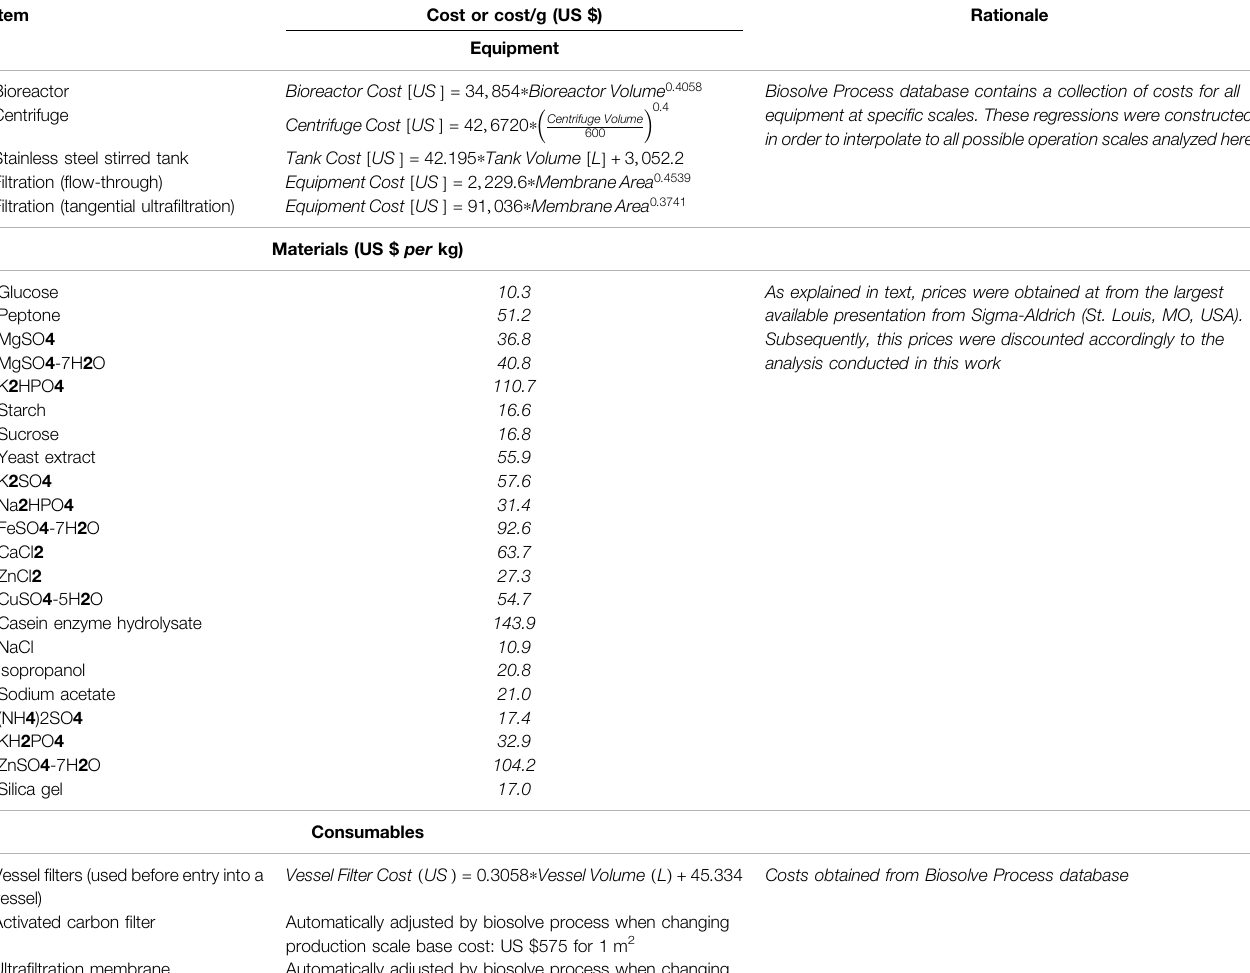
TABLE 3 | Economic dataset employed to populate the model for HA production.